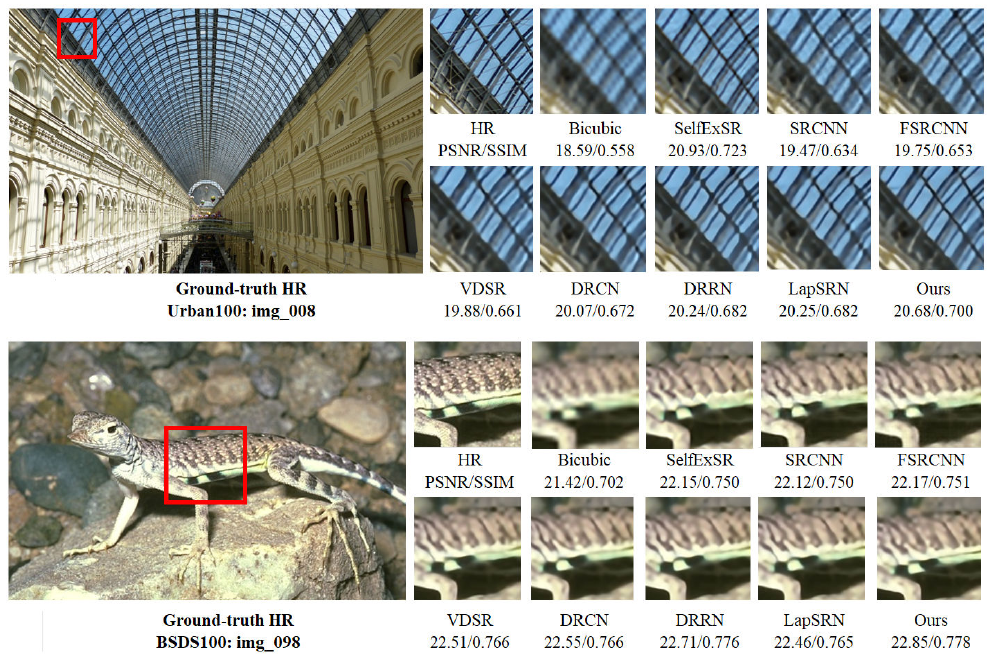
Figure 15. Presents the visual quality performance comparison for 4 × image SR methods on Ur- ban100 and BSDS100